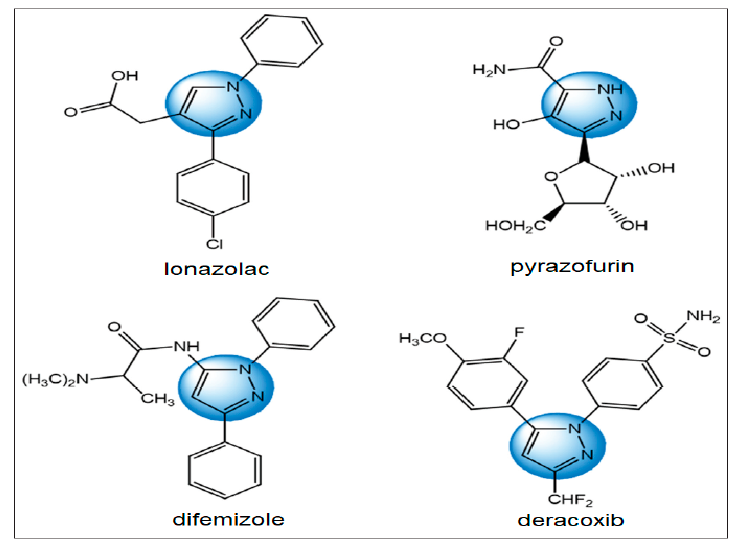
Figure 1. Several commercial drugs containing pyrazole ring.